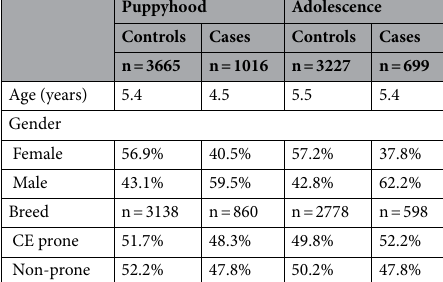
Table 1. Characteristics of the study